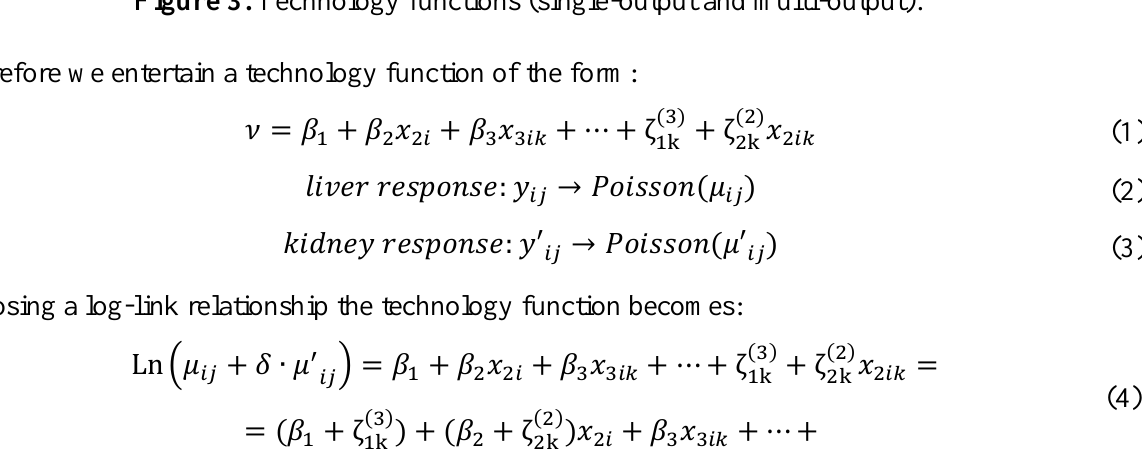
Figure 3. Technology functions (single-output and